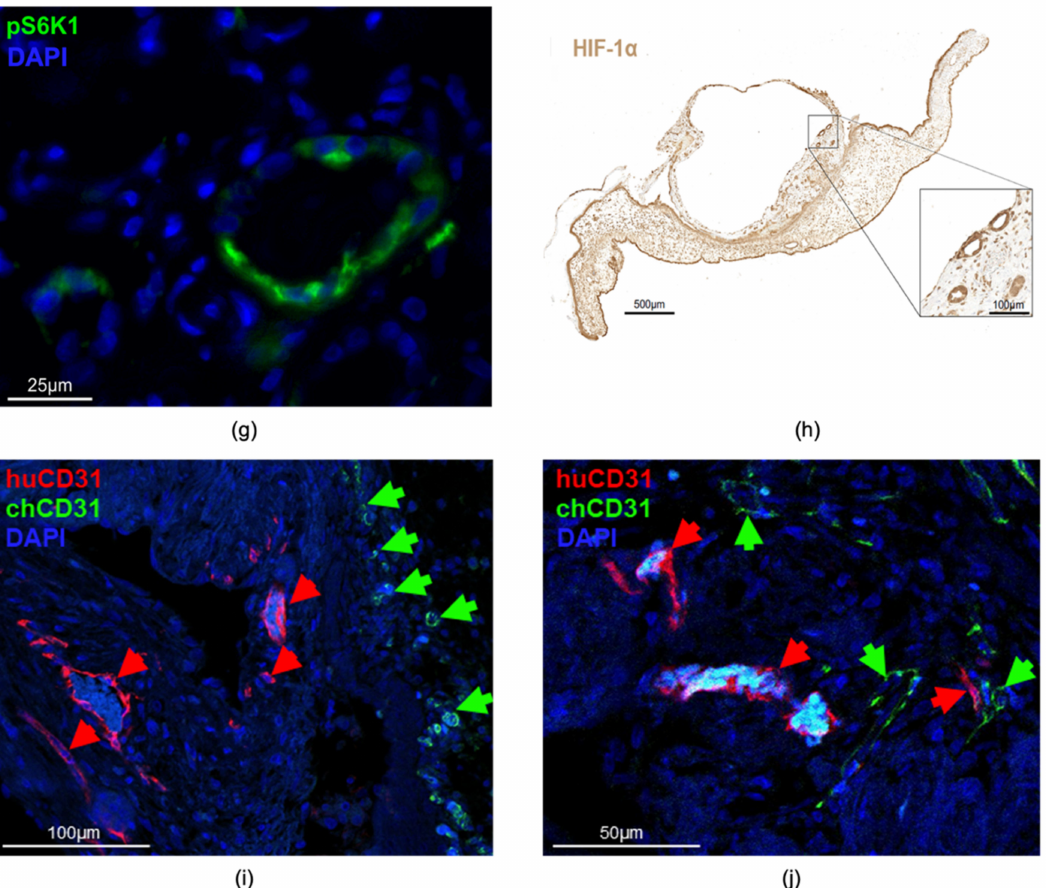
Figure 12. Representative histological and immunohistological staining of human cystic tissue after removal from the CAM; ( a ) overview of hematoxylin/eosin-stained cystic tissue, showing a big cyst within the renal tissue that is surrounded by the CAM; ( b ) vital parts of the cysts stained positive for E-cadherin; ( c ) Dolichos biflorus agglutinin (DBA) and ( d ) acetylated tubulin; ( e ) some of the vimentin-positive cells were also positive for the proliferating cell antigen (PCNA, red arrowheads); ( f ) CD68-positive macrophages and numerous PCNA-positive cells were observed within the cysts; ( g ) phosphorylated S6 kinase 1 (pS6k1) and ( h ) HIF-1 α were detected in cyst-lining cells; ( i ) CD31- positive capillaries originating from human cysts (huCD31, red arrowheads) were clearly separated from chicken-derived CD31-positive capillaries (chCD31, green arrowheads) ( j ) or detected in close proximity. Nuclei were stained with DAPI